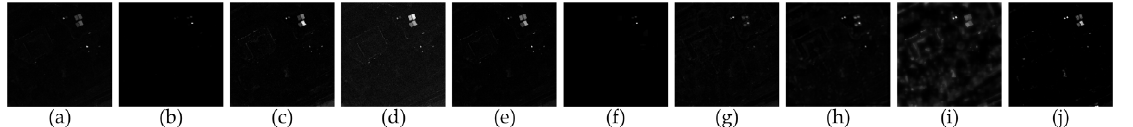
Figure 9. The detection results of different methods on the urban dataset: ( a ) RX; ( b ) LRX; ( c ) LSMAD; ( d ) LSDM–MoG; ( e ) CDASC; ( f ) 2S–GLRT; ( g ) BFAD; ( h ) SSFSCRD; ( i ) AED; ( j ) SCDF.